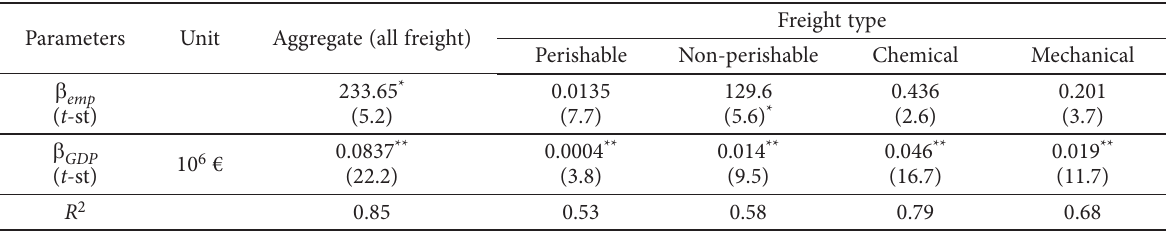
Table 4. Attraction model (import): calibration results in 10 3 tons/year Parameters